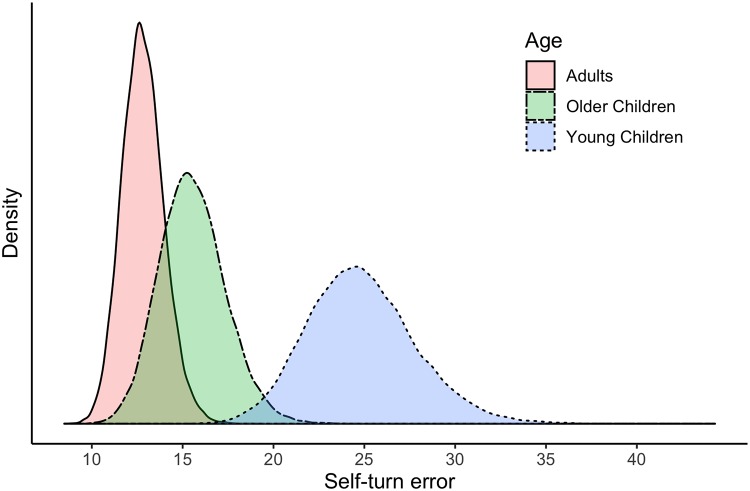
Distributions of the predicted means of self-turn error according to age.(nparticipants = 49; nobservations = 578).